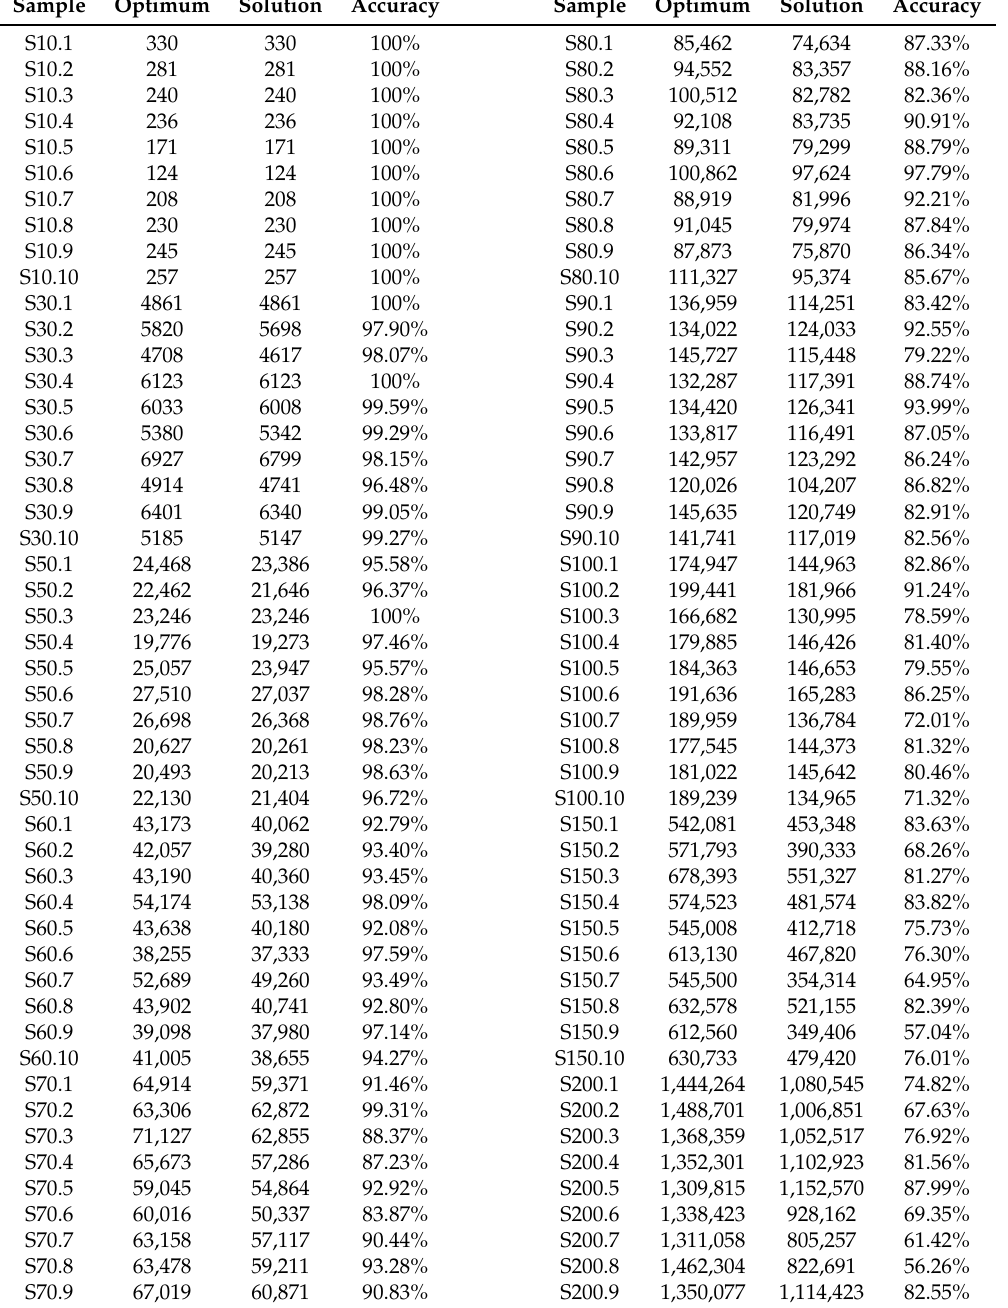
Table 2. Detailed solutions and accuracies for Max-cut problems with different dimensions by supervised learning